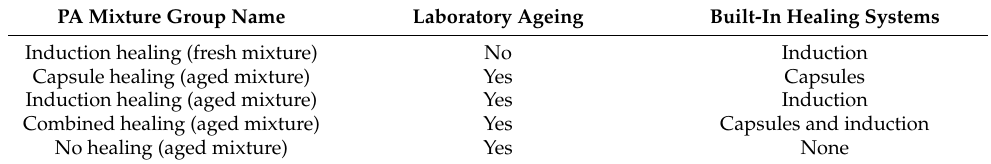
Table 1. PA mixture group information.